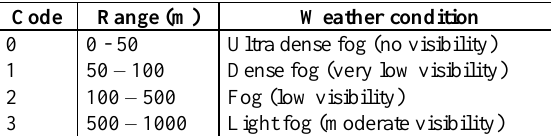
Table 1. Fog relation with visibility